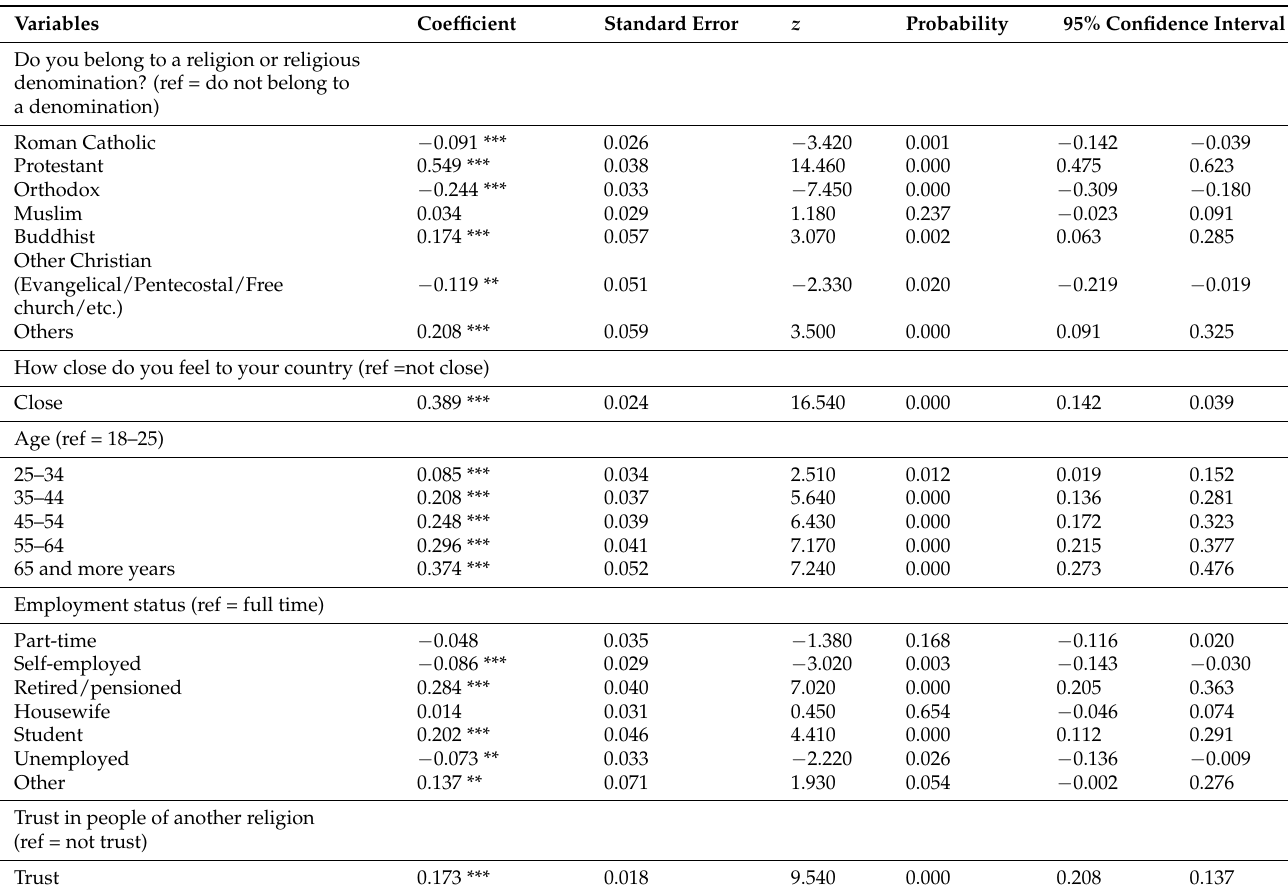
Table 5. The empirical results of tax morality logistic regression model based on mutual information variable selection